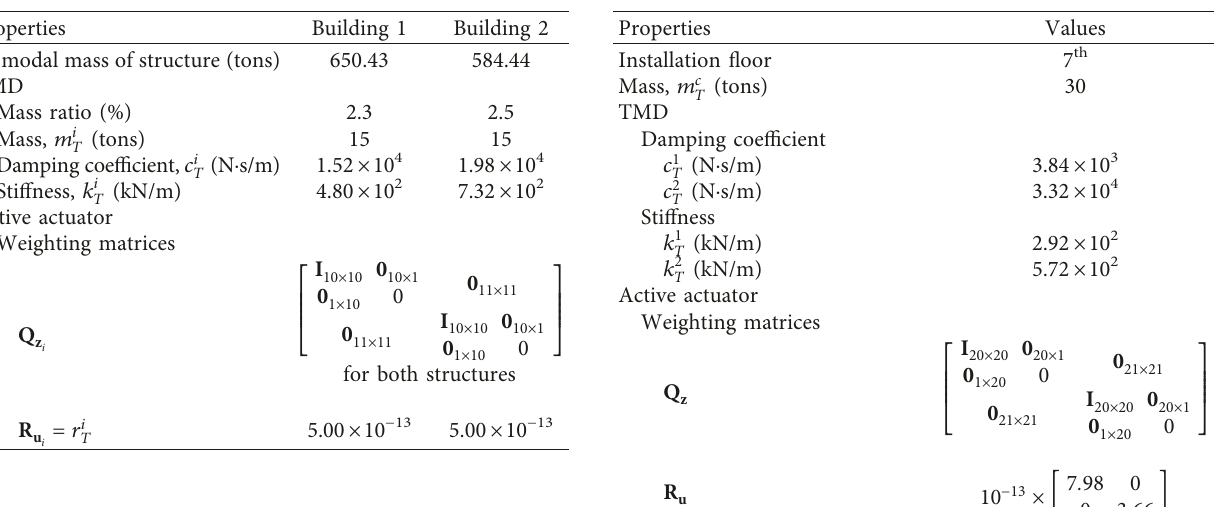
Table 3: GA parameters and searching ranges.